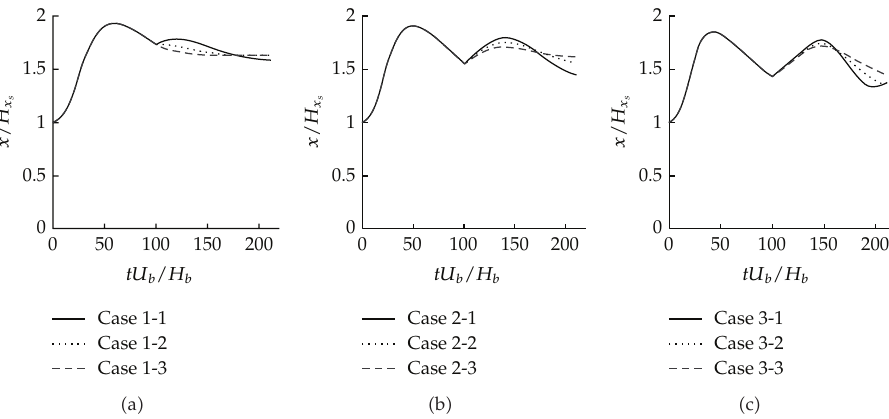
Figure 8: Time lines of concentration center of streamwise direction. (cid:3) a (cid:4) Case 1, (cid:3) b (cid:4) Case 2, and (cid:3) c (cid:4) Case